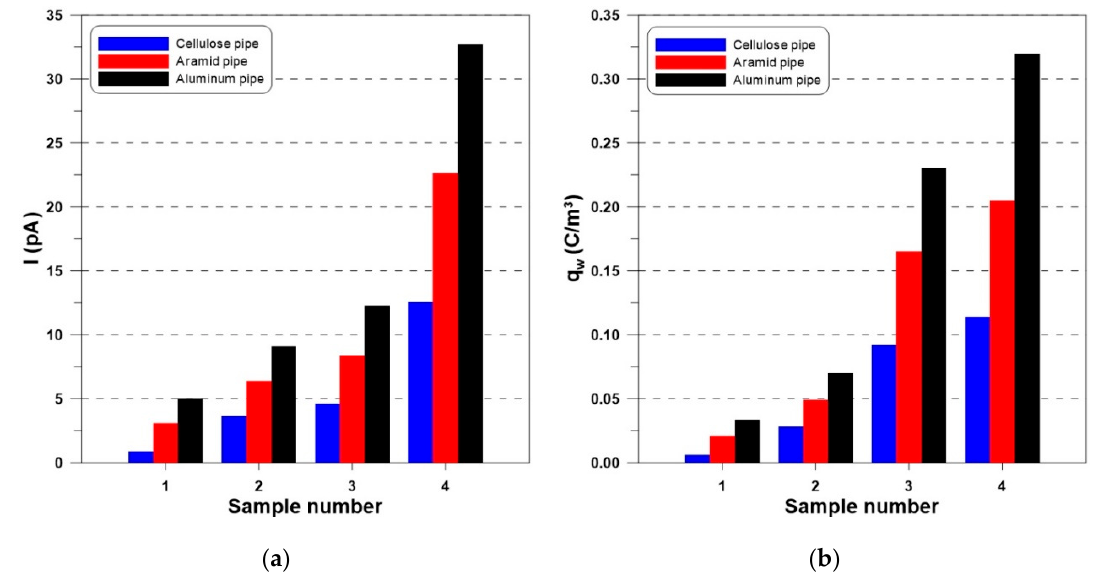
Figure 7. ( a ) Electrification current and ( b ) volume charge density q w vs. pipe material: 1—fresh Trafo EN, 2—aged Trafo EN, 3—Envirotemp FR3, 4—20% (NE)—80% (fresh MO) mixture.